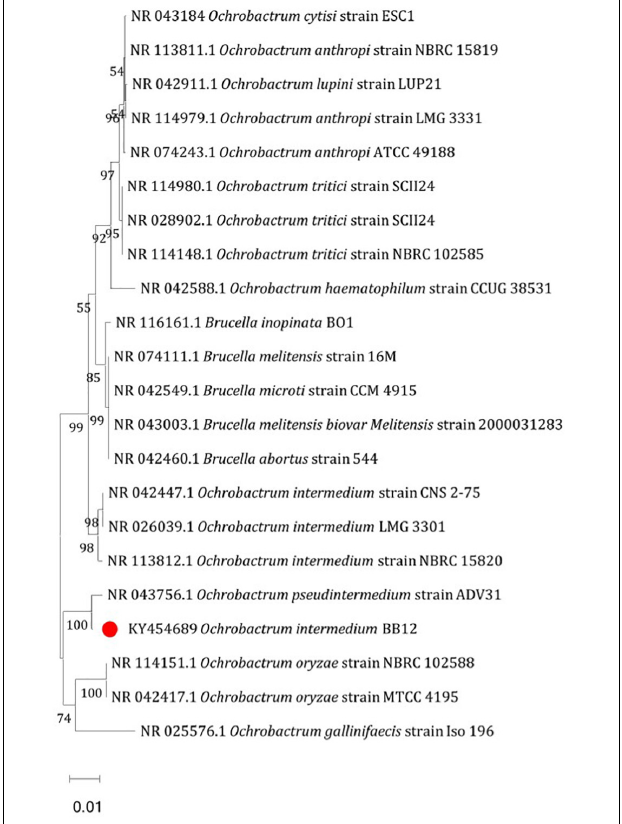
FIGURE 1 | Neighbor-joining tree based on 16S rRNA sequence of heavy metal–tolerant bacteria Ochrobactrum intermedium BB12 by MEGA 6. The bars that corresponded to 0.01 substitutions per nucleotide position were indicative of scales of genetic distances. The numbers at branching nodes indicated the levels of bootstrap support (% of 1,000 replications); only those values above 50% are